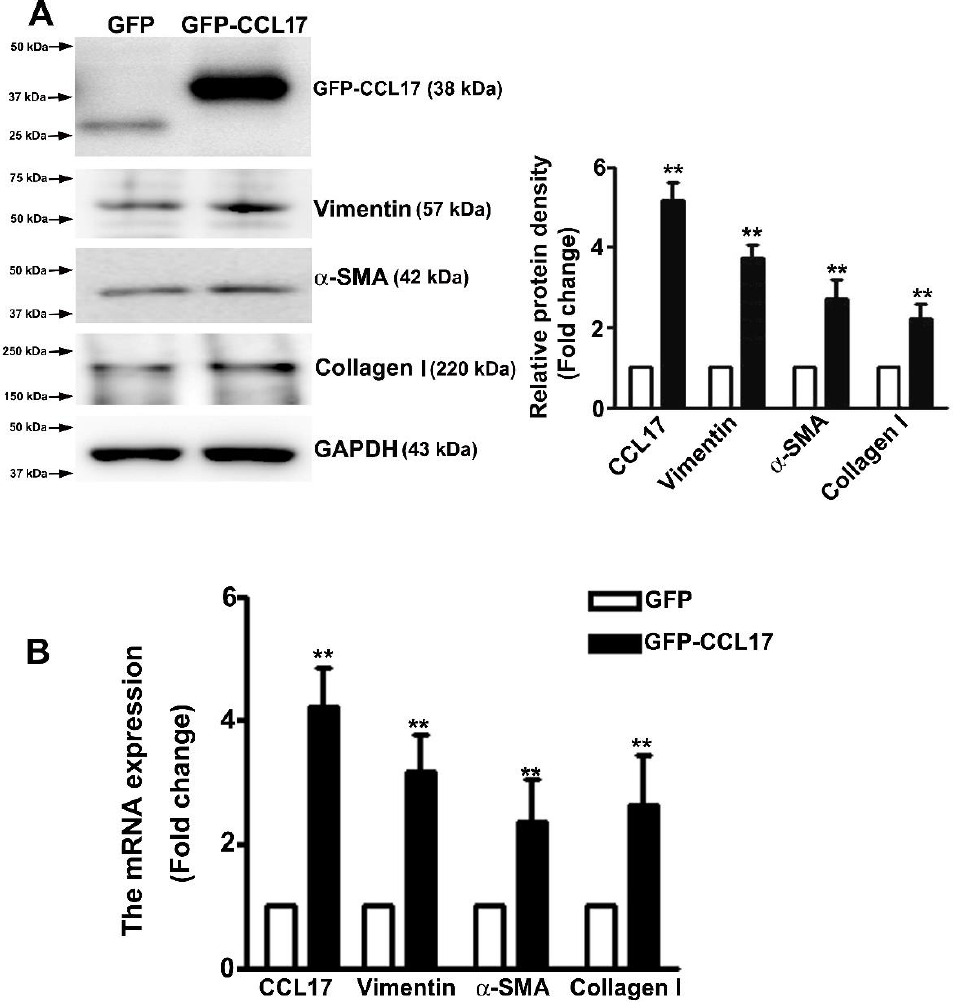
Figure 4. CCL17 regulates EMT-related protein and mRNA expression in HK2 cells; ( A ) Western blot analysis of total HK2 cell lysates to determine the protein expression of CCL17, collagen I, α -SMA, and vimentin. The relative protein density is shown as histograms in the right panel. GAPDH was used to normalize protein loading; ( B ) qRTPCR assay of mRNA expression of CCL17, collagen I, α -SMA, and vimentin. GAPDH was used to normalize mRNA loading. Results are expressed as the mean ± SD of at least three independent experiments. ** p < 0.01 compared with GFP cells.